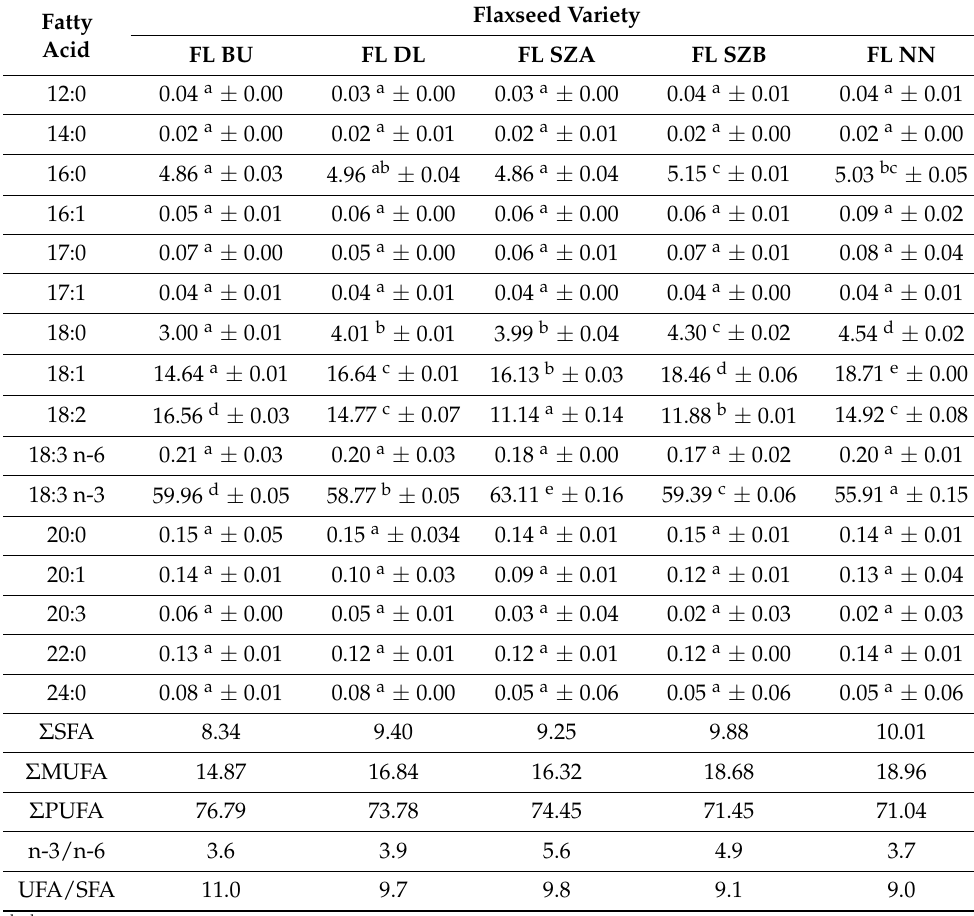
Table 1. Fatty acid composition expressed as a percentage of total fatty acid (%). Saturated fatty acid (SFA), monounsaturated fatty acid (MUFA), polyunsaturated fatty acids (PUFA) and a ratio of n-3 to n-6 and unsaturated to saturated fatty acids (UFA /SFA) of different cultivars of cold-pressed flaxseed